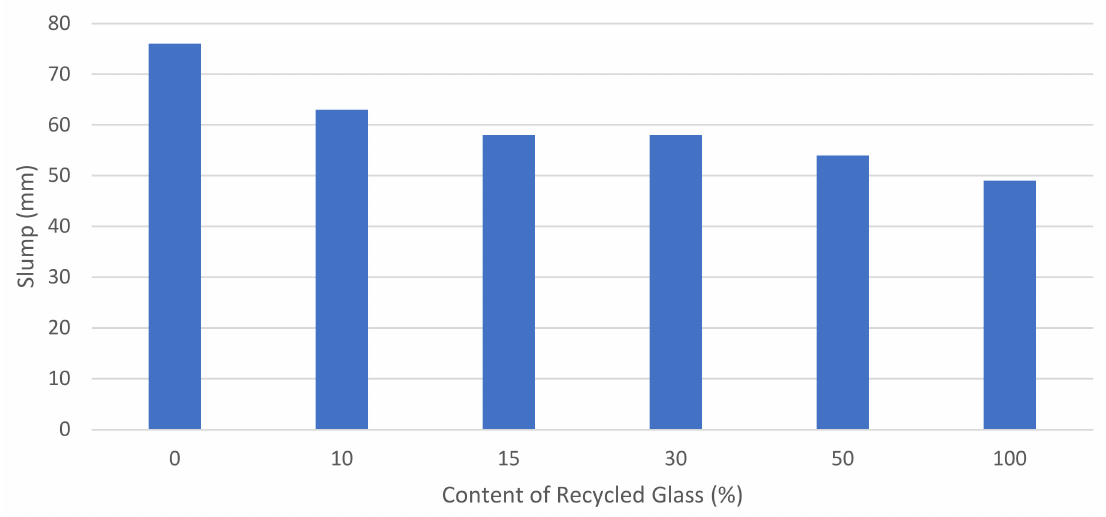
Figure 8. Effect of percentage glass waste substitutions for sand on the workability by slump.